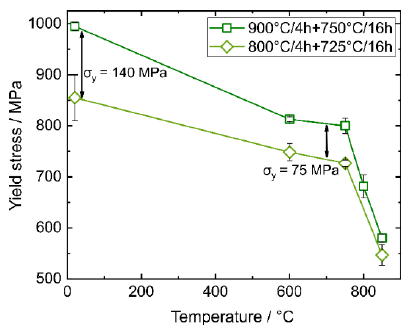
Figure 6. Yield stress under compression as a function of the testing temperature of two fully heat-treated conditions.